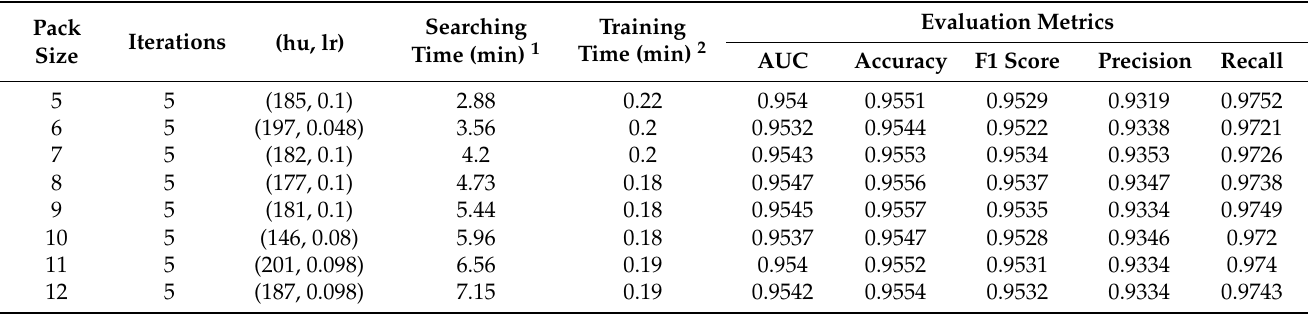
Table 4. Hu and lr obtained under different pack size and the experimental results.